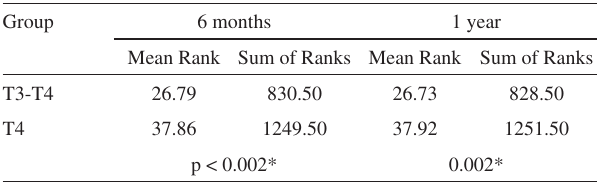
Table 3 - Patient satisfaction rates